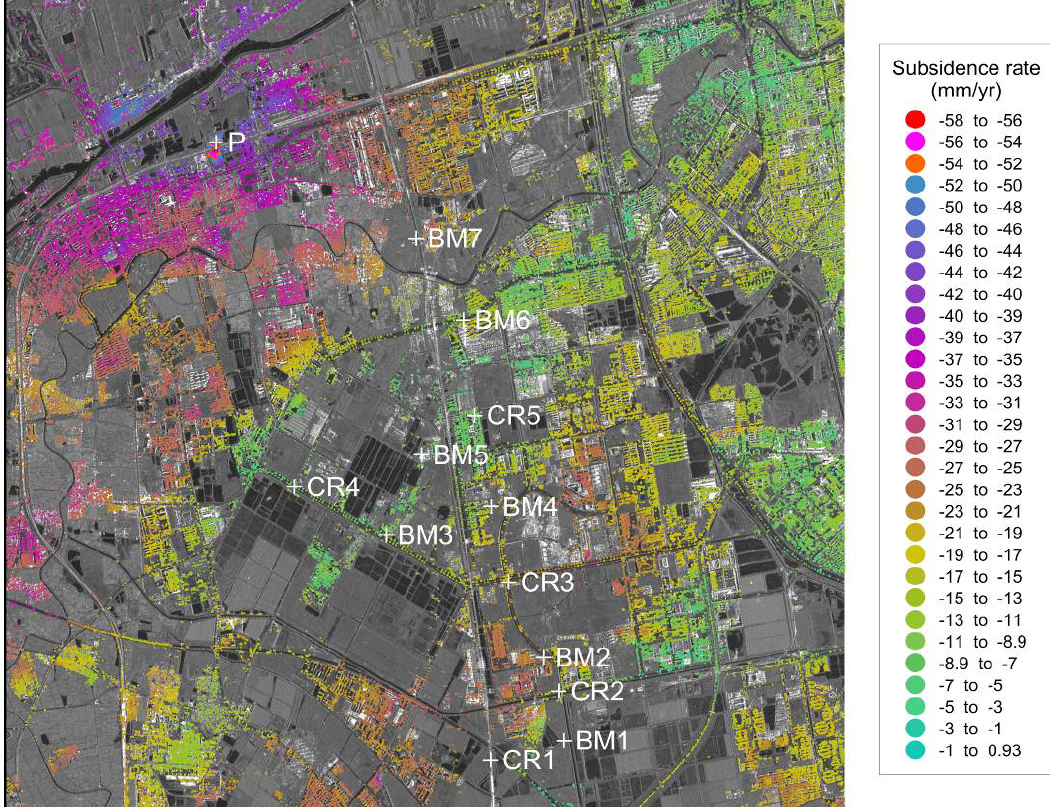
Figure 7. Subsidence rates estimated for all the valid TCPs using the 111 LSB interferometric